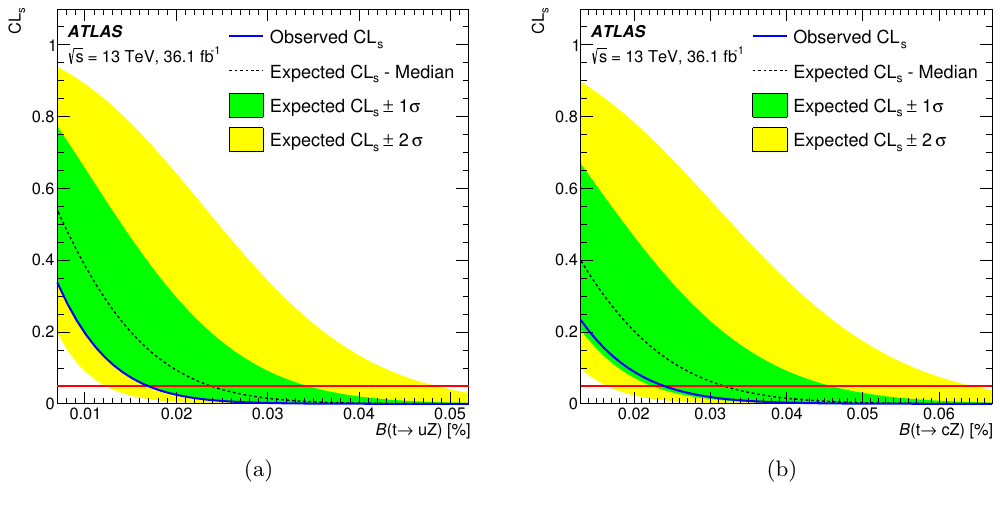
Figure 4 . (a) CL s vs B ( t ! uZ ) and (b) CL s vs B ( t ! cZ ) taking into account systematic and statistical uncertainties. The observed CL s values (solid line) are compared to the expected (median) CL s values under the background-only hypothesis (dashed line). The surrounding shaded bands correspond to the 68% and 95% CL intervals around the expected CL s values, denoted by (cid:6) 1 (cid:27) and (cid:6) 2 (cid:27) , respectively. The solid line at CL s = 0.05 denotes the threshold below which the hypothesis is excluded at 95%